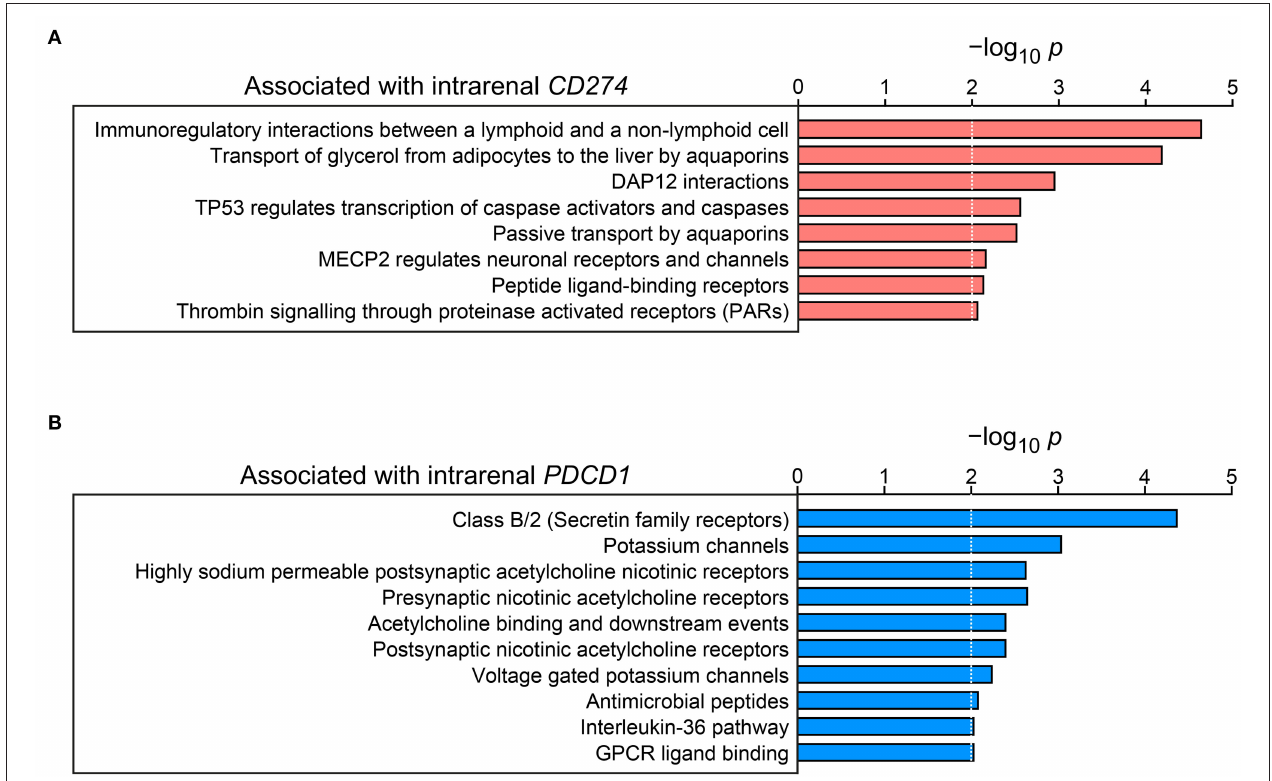
FIGURE 4 | Identification of signaling pathways associated with tubulointerstitial PD-L1 and PD-1. (A) Entities –log 10 p values of signaling pathways for gene enrichment positively associated with tubulointerstitial CD274 mRNA expression are shown (the dotted lines correspond to the predefined threshold value of p ≤ 0.01). (B) Entities –log 10 p values of signaling pathways for gene enrichment positively associated with tubulointerstitial PDCD1 mRNA expression are shown (the dotted lines correspond to the predefined threshold value of p ≤ 0.01). PD-1, programmed cell death protein 1; PD-L1, programmed cell death protein 1-ligand 1.